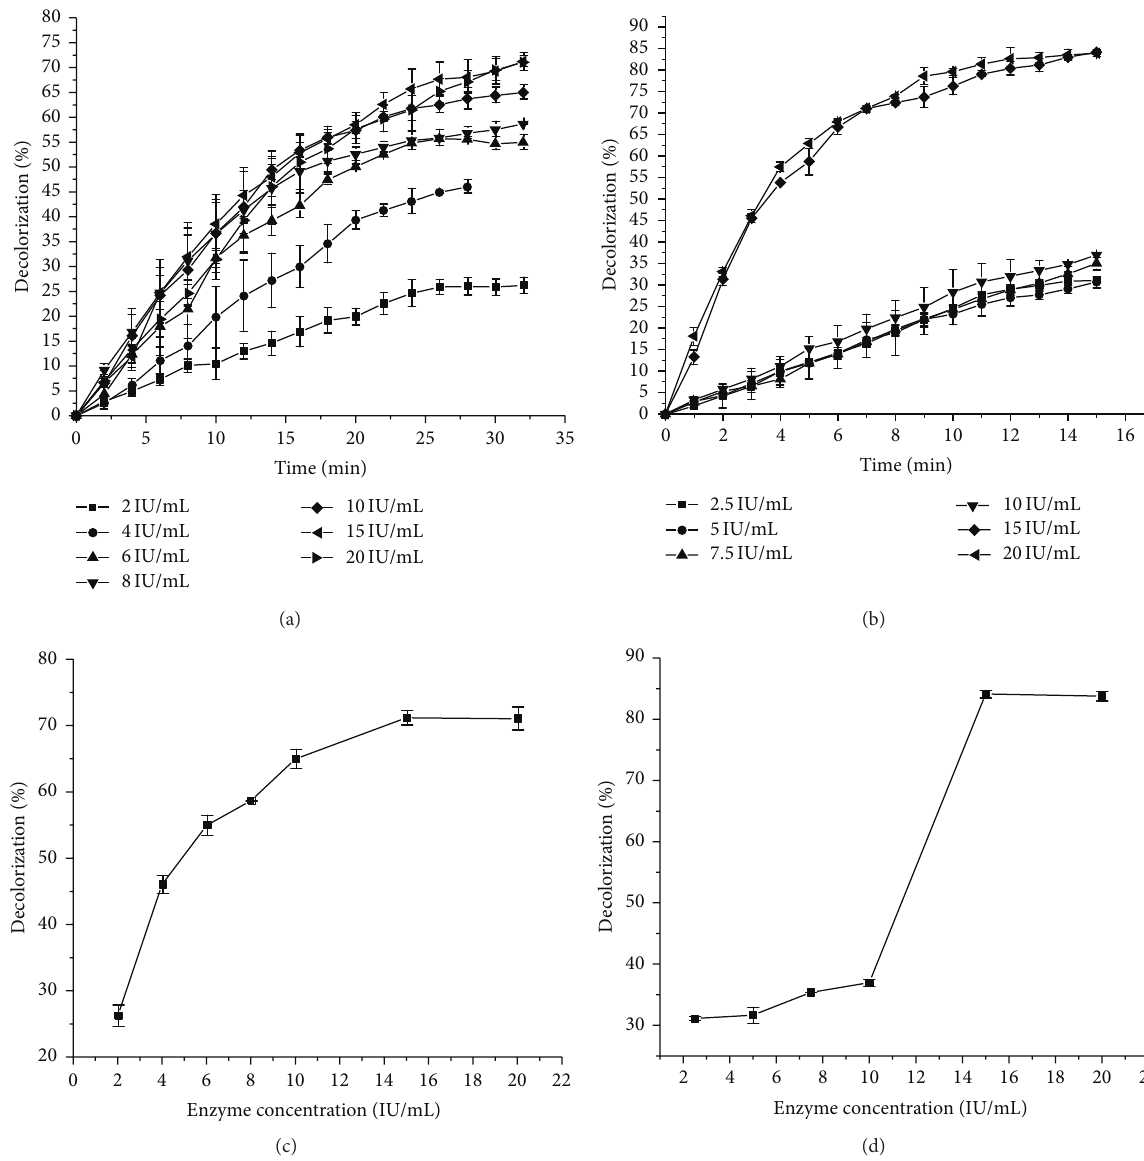
Figure 3: (a) Time course of decolorization of AB 225 and (b) AV 109 dyes at different initial enzyme concentration. (c) The influence of the initial enzyme concentration on the decolorization percentage for AB 225 and (d) AV 109. Reaction conditions for AB 225: treatment time 32 minutes, dye concentration 30 mg/L, hydrogen peroxide concentration 1mM, pH 5.25, temperature 24 ∘ C, and for AV 109: treatment time 15 minutes, dye concentration 30 mg/L, hydrogen peroxide concentration 2mM, temperature 24 ∘ C, pH 5.5. Each value represents the average of three